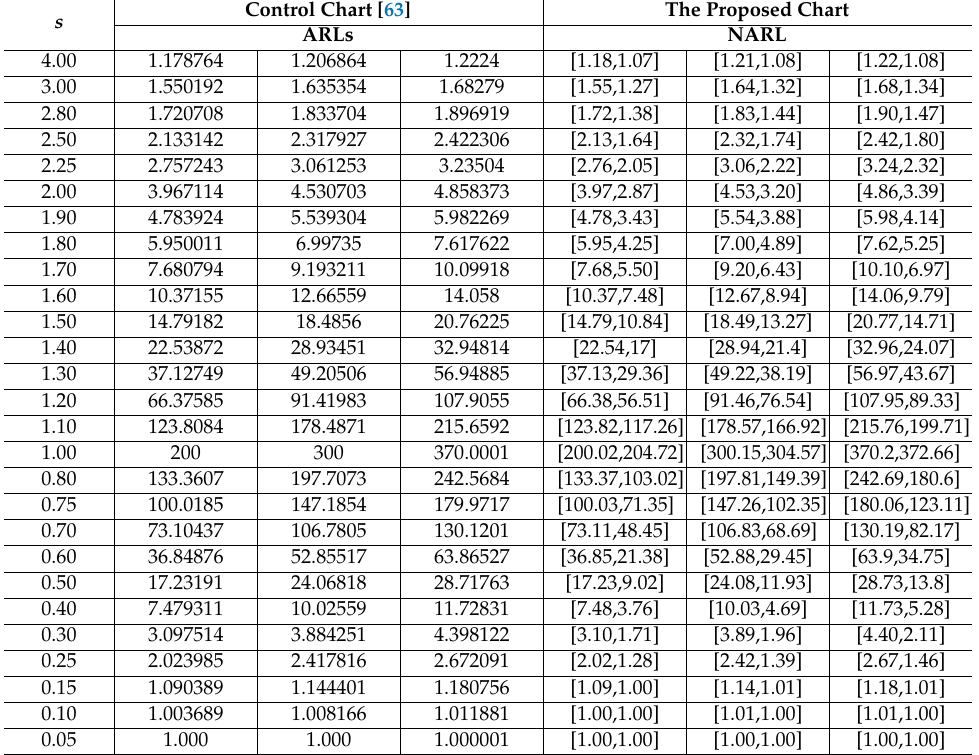
Table 5. Comparison of average run length values at di ff erent levels of shift when a = 0.95 and k =